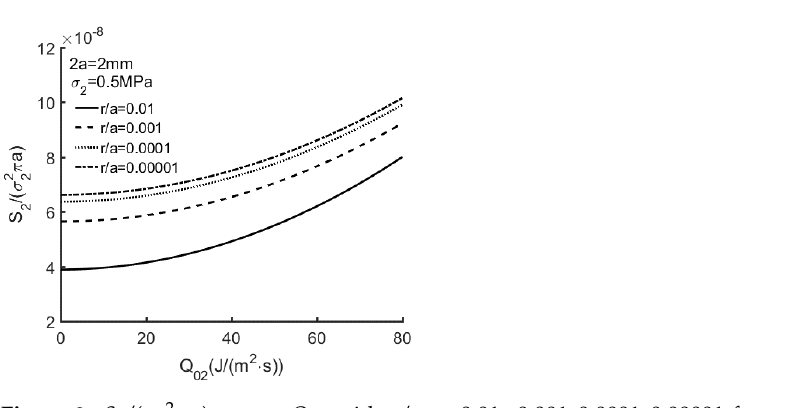
Figure 9. S 2 / ( σ 22 π a ) versus 𝑄 02 with 𝑟/𝑎 = 0.01,0.001,0.0001 ， 0.00001 for 𝜛 𝑐 = 0 and 𝜀 = 0.01. (2 a =